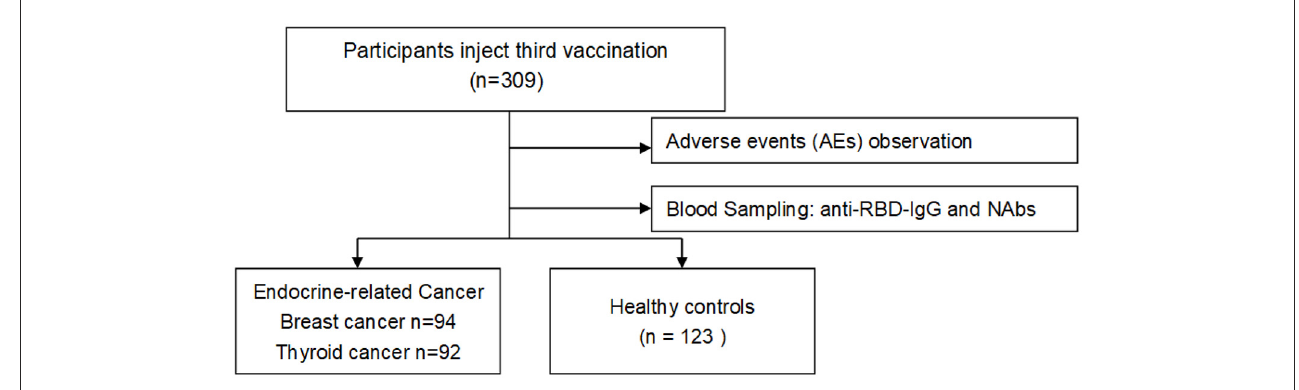
FIGURE1 Flowchart of the study.